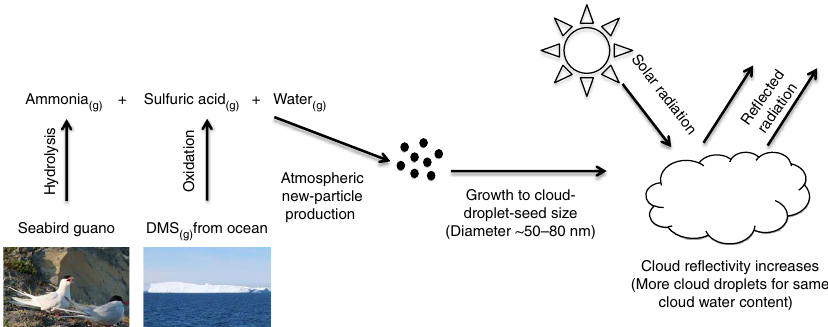
Figure 1 | Seabird–climate coupling. Schematic summary of processes that couple Arctic seabird-colony ammonia emissions with climate. NATURE COMMUNICATIONS|7:13444|DOI: